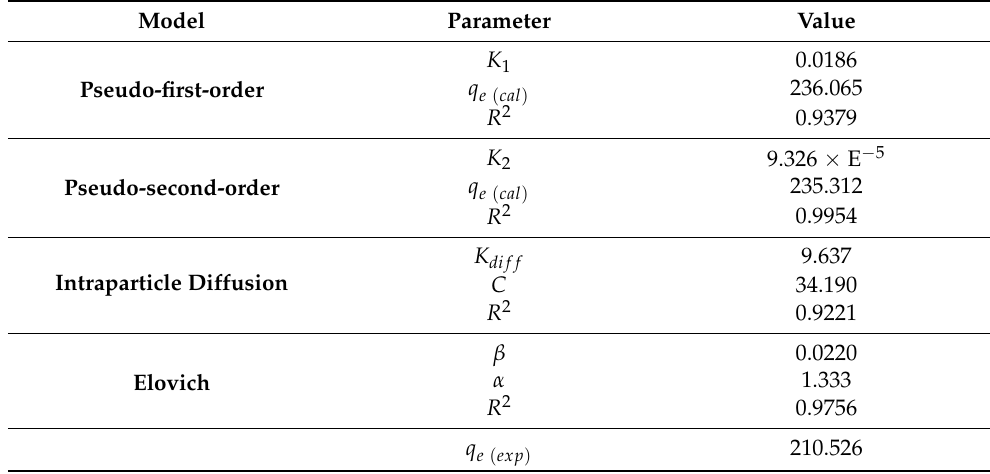
Figure 5. Study of the kinetics of heparin adsorption over QDASi using the pseudo-first-order ( a ); pseudo-second-order ( b ); intraparticle diffusion ( c ); and Elovich ( d ) methods. Table 2. Parameters calculated from different kinetic study models of heparin adsorption on QDASi.